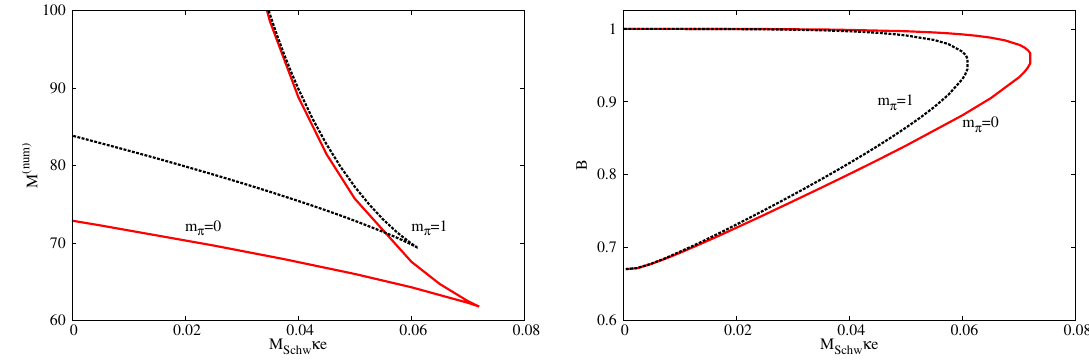
Figure 2 . Mass (left panel) and baryon charge (right panel) for Skyrmions on a Schwarzschild BH, in terms of the coupling (cid:11) = M Schw (cid:20)e , for two illustrative values of the pion